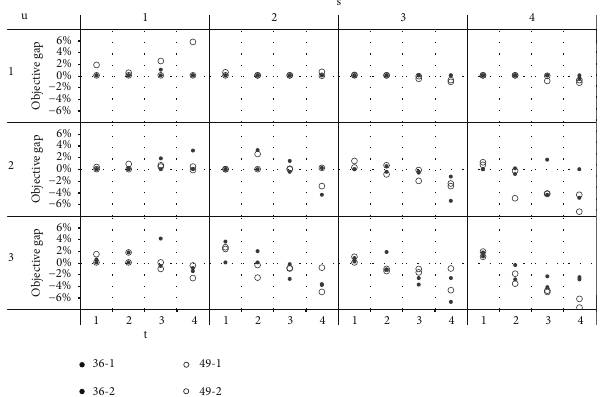
Figure 4: Objective gap between NGRASP and Benders. 36- and 49-node